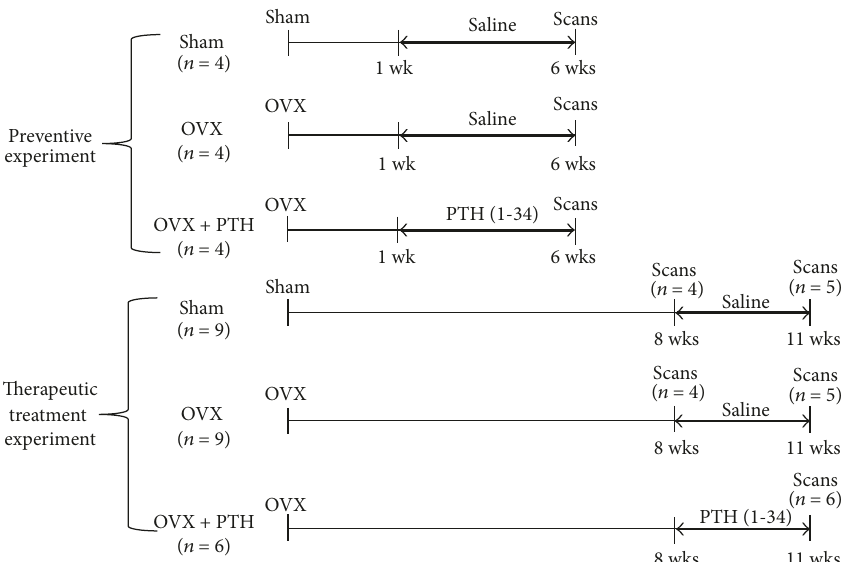
Figure 1: Line diagrams showing experimental design for PTH treatment of ovariectomized rats. The time after operation is shown below the line and the type of treatment (PTH or saline) is shown above the bold arrow. In experiment 1 (preventive experiment), 1 week after operation the rats received daily injections during 5 weeks whereas in experiment 2 (therapeutic treatment experiment) rats were permitted to lose bone for 8 weeks before the initiation of treatments and were treated for 3